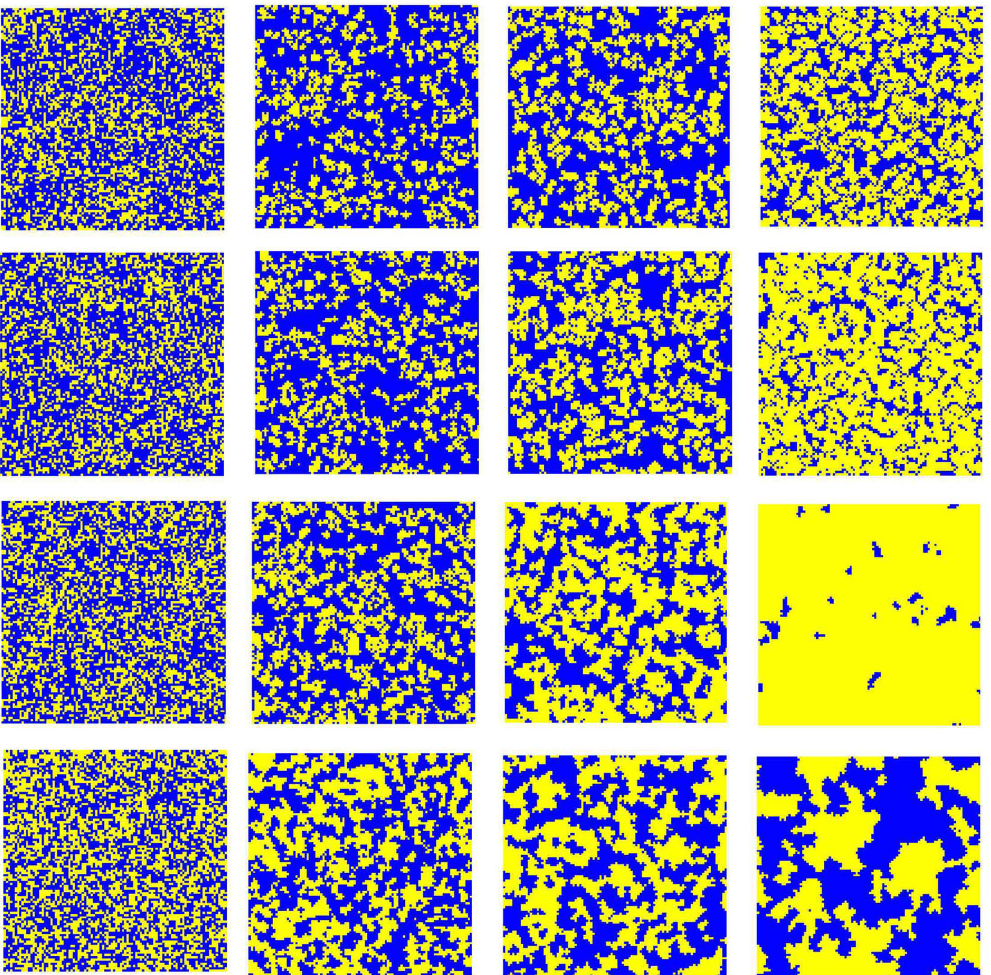
Figure 6. Snapshots of the distribution of cooperators (yellow) and defectors (blue) for α = 3.0. From left to right, the MCS steps are 0, 10, 100 and 10000, respectively. From top to bottom, u are equal to 0, 0.4, 0.8, and 1.0, respectively. The temptation to defect b = 1.1 and other parameters are the same as those in Fig.